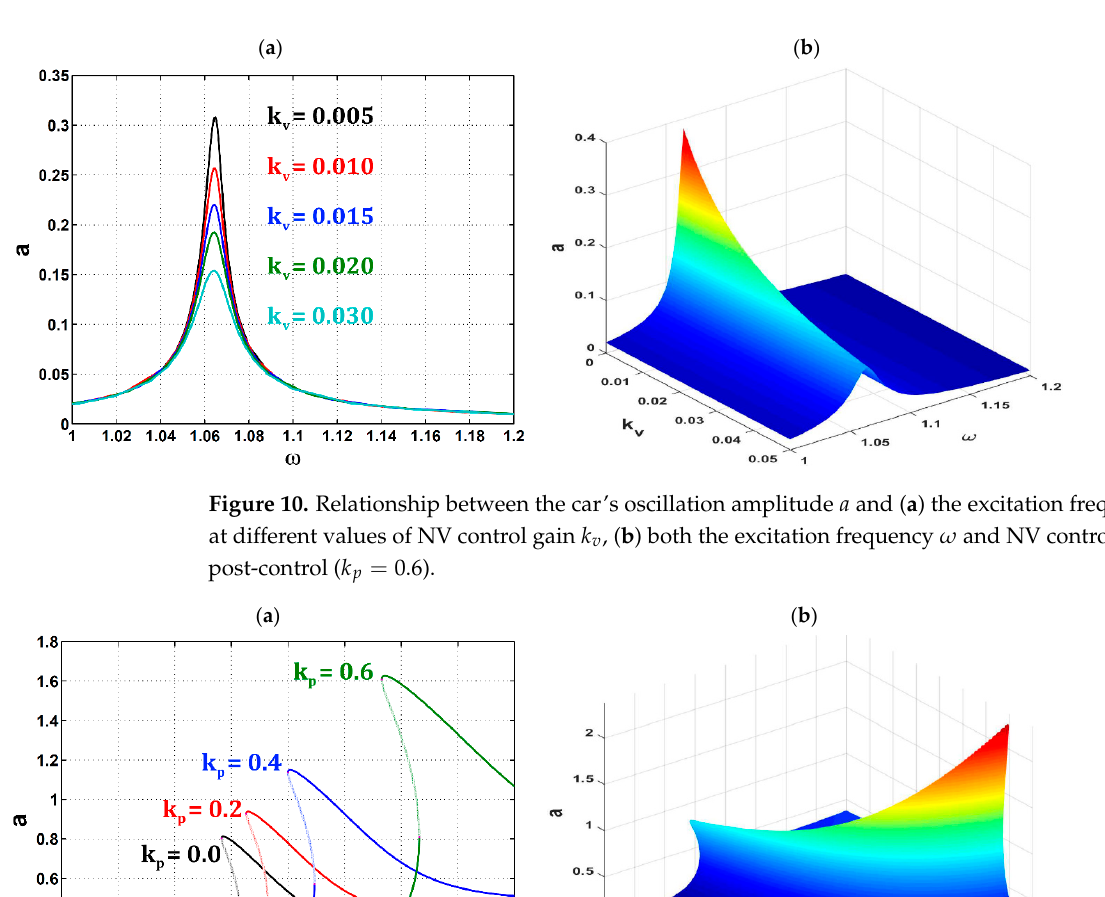
Figure 9. Relationship between the car’s oscillation amplitude (cid:1853) and ( a ) the excitation frequency (cid:2033) at different values of CP control gain (cid:1863) (cid:3043) , ( b ) both the excitation frequency (cid:2033) and CP control gain (cid:1863) (cid:3043) post-control ( (cid:1863) (cid:3049) = 0 ).